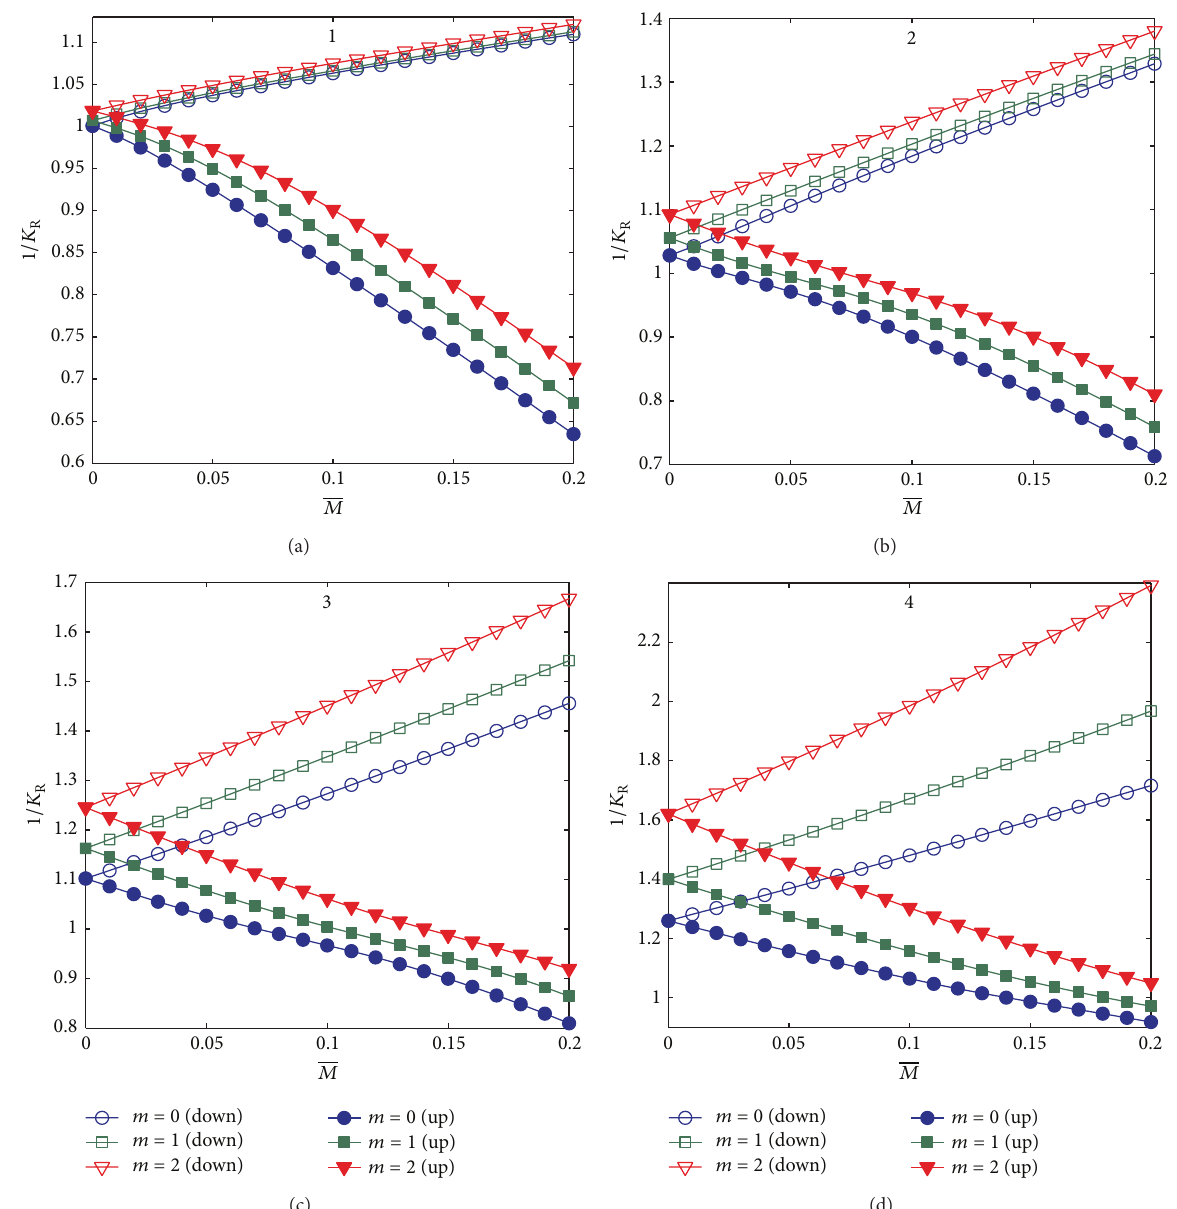
Figure 4: (Color online) Comparison of the relative phase velocity of the first four axial pseudo-modes among the three circumferential modes ( 𝑚 = 0 , 𝑚 = 1 , and 𝑚 = 2 ) in the laminar flow confined by the lined-walled pipeline.